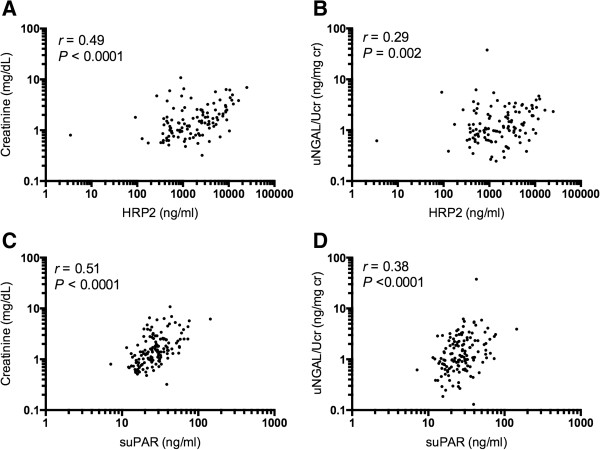
Correlations of variables involved in acute kidney injury. Correlations of variables proposed to be involved in the pathogenesis of acute tubular necrosis in malaria associated AKI with marker of renal dysfunction (creatinine) and marker of kidney damage (uNGAL/Ucr). Pearson’s correlation coefficient between plasma P. falciparum histidine rich protein 2 (HRP2) and (A) serum creatinine; and (B) uNGAL/Ucr. Pearson’s correlation coefficient between suPAR and (C) serum creatinine; and (D) uNGAL/Ucr. All variables were log transformed (log10) for correlation plots and Pearson’s analysis. suPAR = soluble urokinase–type plasminogen activator receptor; uNGAL/Ucr = urine neutrophil gelatinase-associated lipocalin corrected for urine creatinine.